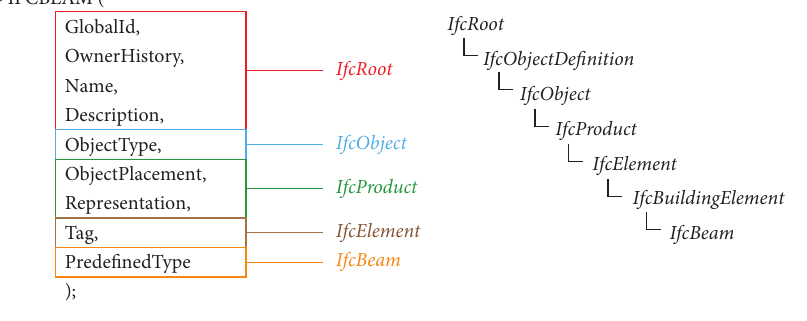
Figure 2: IFC attribute inheritance.